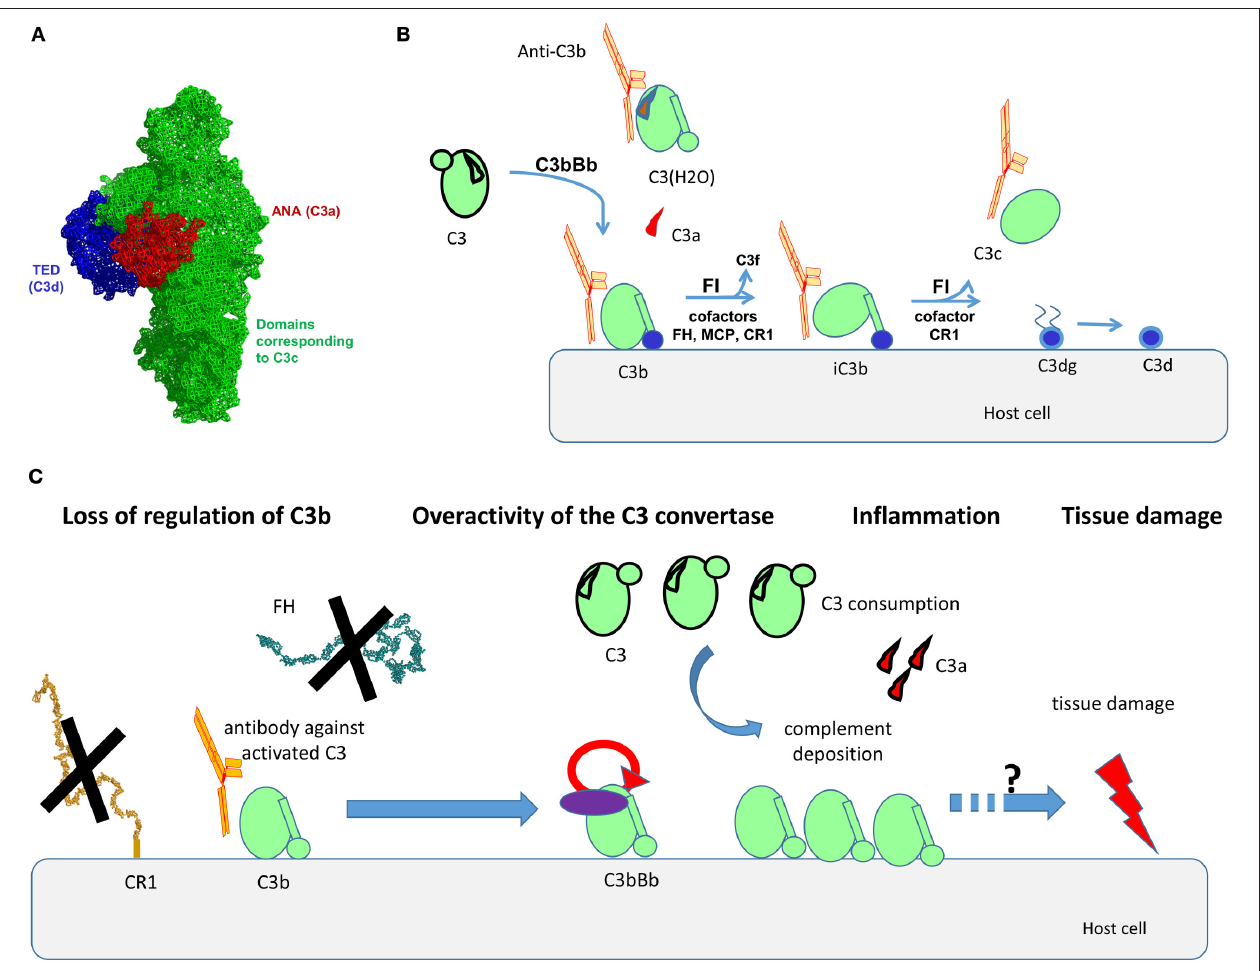
FIGURE 1 | Structural organization of C3, its activation forms, localization of the binding epitopes, and proposed mode of action of the anti-C3b auto-antibodies. (A) Structural organization of C3 , based on the crystal structure published in Janssen et al. ( 8). The different domains, corresponding to the different fragments of the molecule are depicted with different color. Of note are the ANA domain, corresponding to C3a (red), the domains corresponding to C3c (green), and the TED domain, corresponding to C3d (blue). (B) Steps of cleavage of C3 by the C3 convertase of the alternative pathway C3bBb and generation of its activation forms. The cofactors needed for the cleavage of C3b by Factor I (FI) are indicated. The activation forms of C3, recognized by the autoantibodies (C3(H2O), C3b, iC3b, C3c) are indicated as complexed with an antibody in orange. (C) Proposed mode of action of the anti-C3b autoantibodies. The Ab will bind to C3b, preventing its interaction with CR1, and in the context of lupus nephritis, with Factor H (FH). This loss of regulation, together with the direct stabilization/enhancement of formation of the alternative pathway C3 convertase C3bBb will result in overactivation of complement, generating inflammation (via C3a), massive deposits of C3 activation fragments and finally, tissue damage. The exact mechanism linking complement overactivation to tissue injury and its contribution to organ injury need further